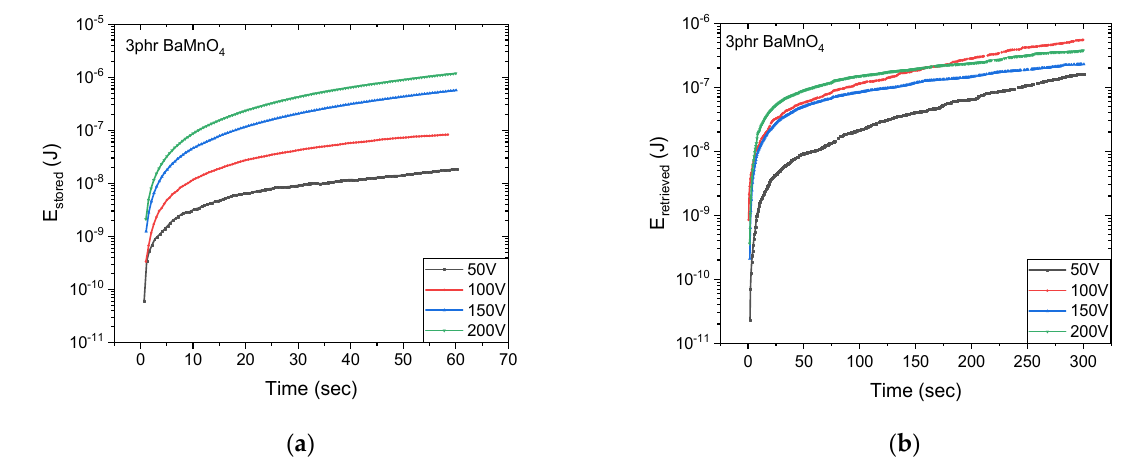
Figure 3. ( a ) Stored (charging procedure) and ( b ) retrieved (discharging procedure) energies (E stored , E retrieved ) as a function of time for the 3 phr BaMnO 4 nanocomposite at different DC voltage levels. Figure 4a,b depict the stored and retrieved energies as a function of time at 50, 100, 150 and 200 V for the 15 phr BaMnO 4 specimen.